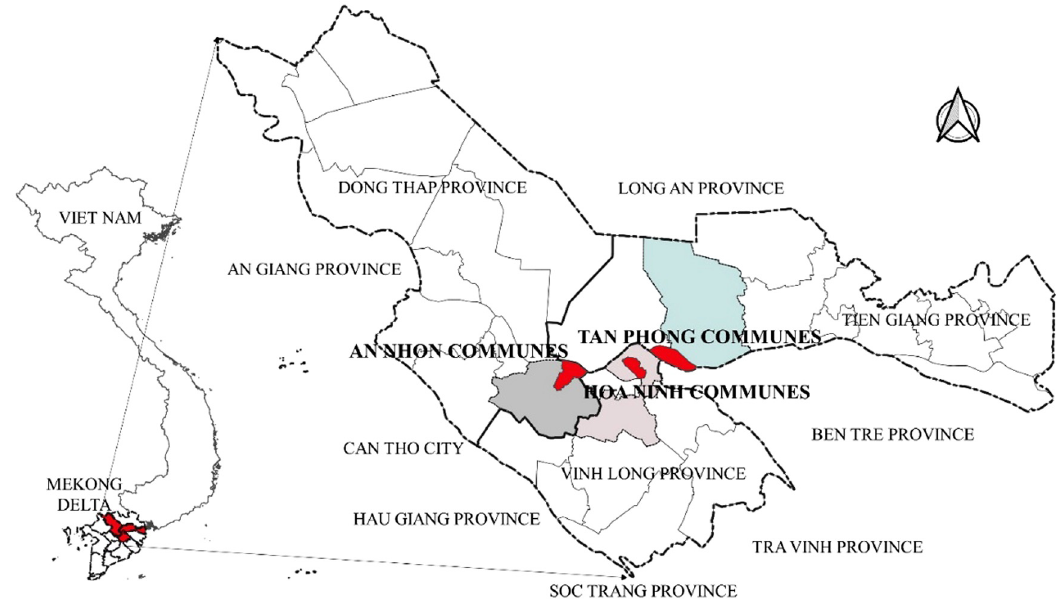
Figure 1: Study sites. The interview communes are red in the map. The study sites were Hoa Ninh commune, Long Ho district, Vinh Long province; Tan Phong commune, Cai Lay district, Tien Giang province and An Nhon commune, Chau Thanh district, Dong Thap